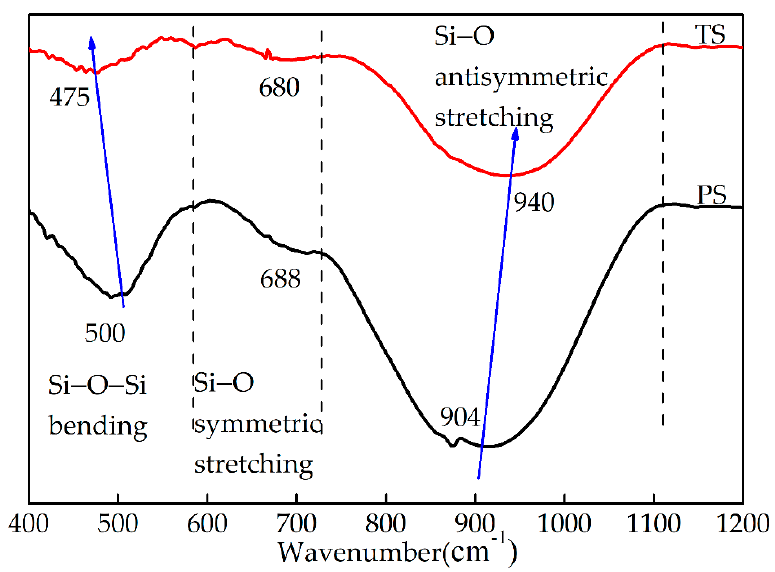
Figure 4. FTIR spectroscopy of two kinds of water-quenched slag.